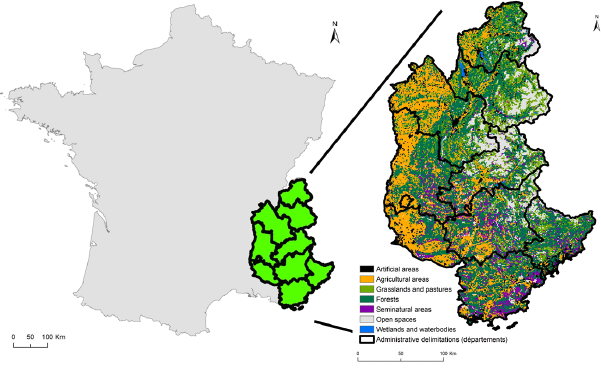
Fig. 2 . The French Alps in France (left). Main land covers in the French Alps